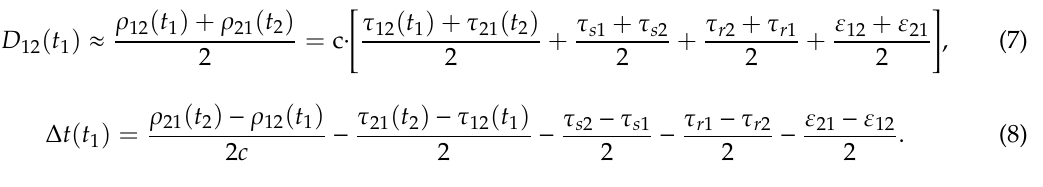
Figure 4. Principle of dual one-way ranging measuring.